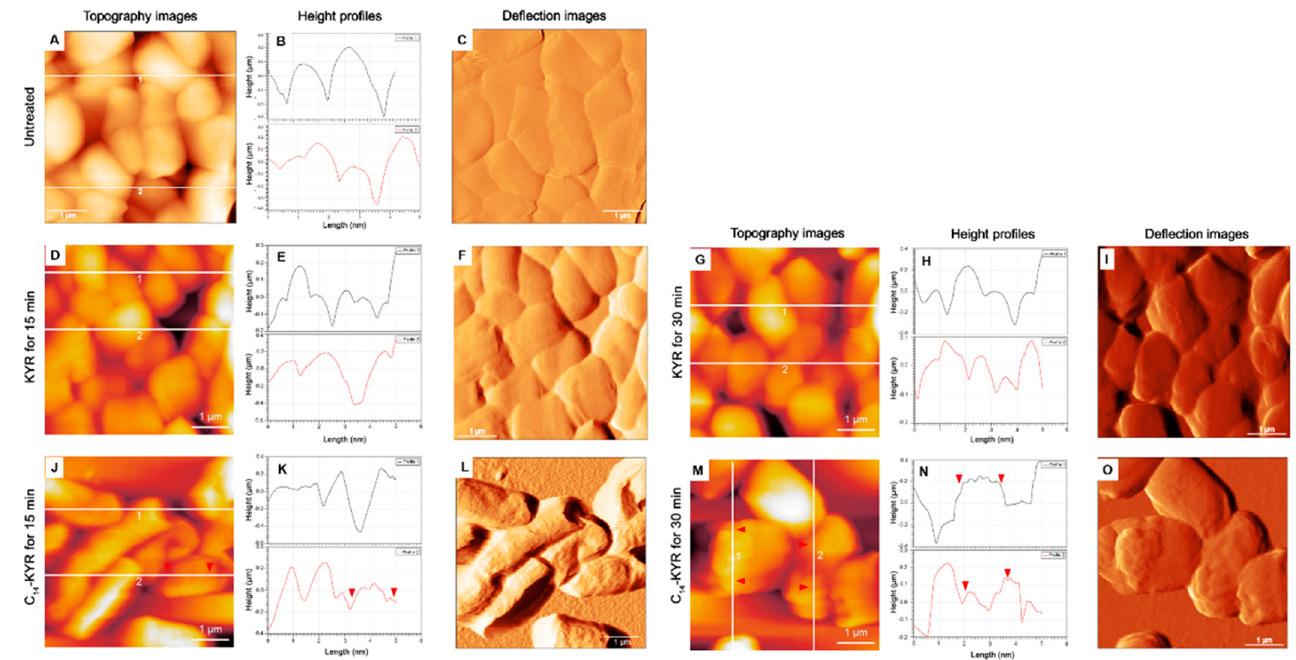
Figure 2. AFM images, height profiles, and deflection images of E. coli HB101 cell population in solution at mid-logarithmic phase before ( A – C ) and after treatment with either 20 µM of KYR ( D – I ) or 20 µM of C 14 -KYR ( J – O ) for 15 and 30 min, respectively. KYR slightly caused damage on the cell surface, while the rod shape was maintained after treatment for 15 ( D – F ) and 30 min ( G – I ). C 14 -KYR induced roughness on the cell surface after treatment for 15 ( J – L ) and 30 min ( M – O ). AFM images in 5 µm × 5 µm were performed using a silicon nitride cantilevers with a spring constant of ~0.12–0.14 N/m, a resonant frequency of 5 kHz, and a scanning speed 0.5 Hz.